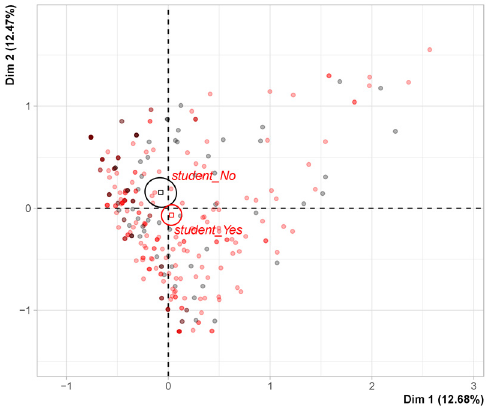
Figure A13. MCA. Distribution of respondents by academic status.